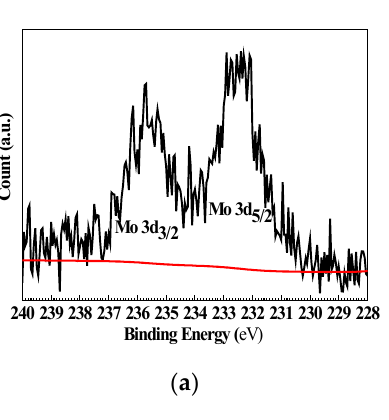
Figure 9. High-resolution XPS of Mo 3d for Q235 samples polarized to E p in MoO 4 2− + Cl − and WO 4 2−